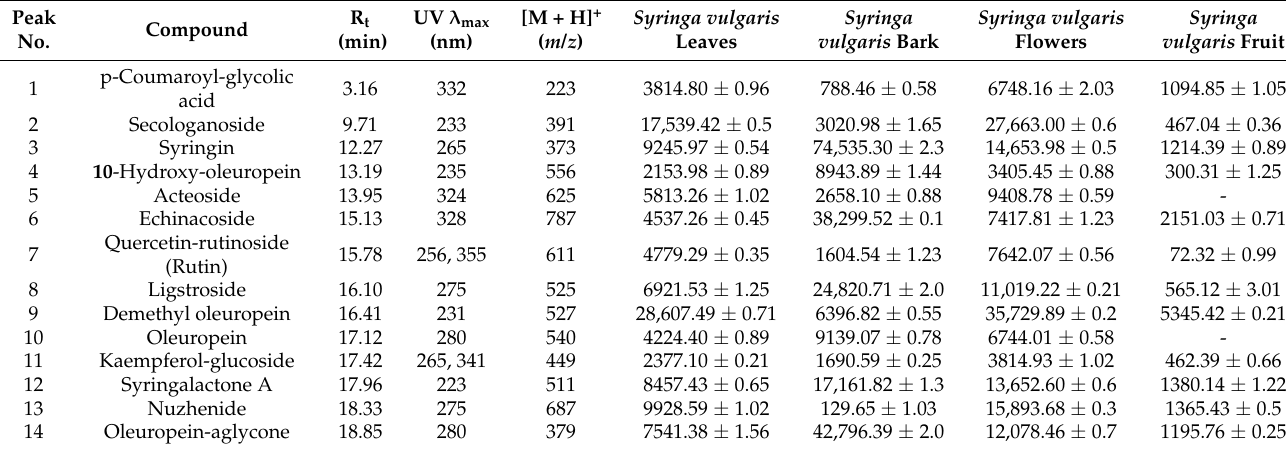
Note: Values represent the mean ± standard deviations of three measurements.